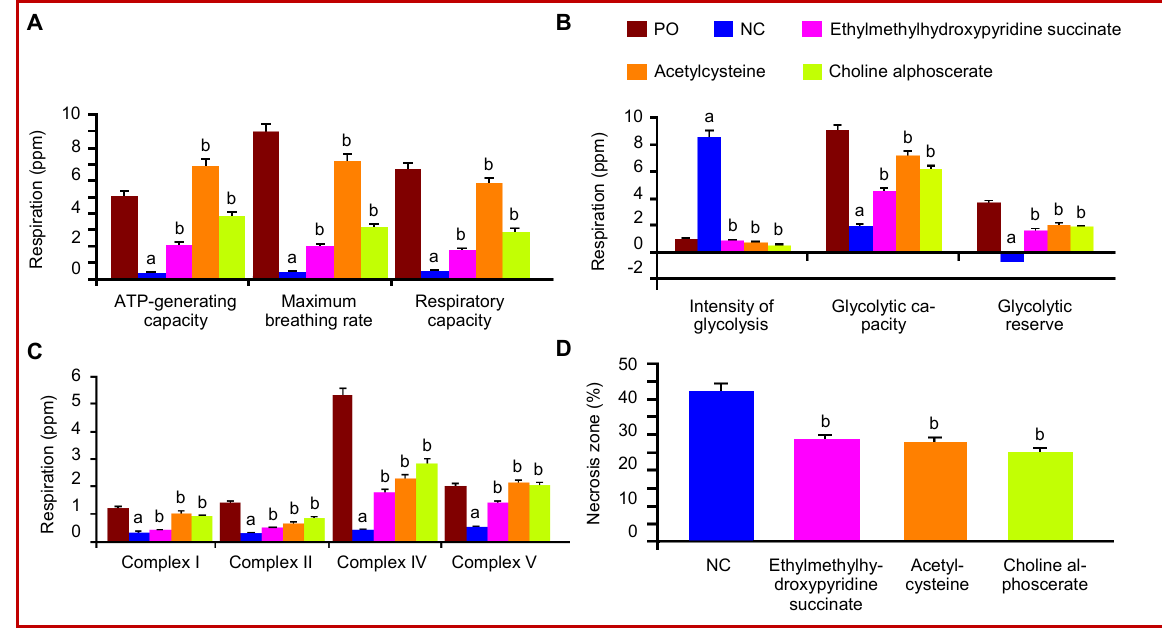
Figure 2: The effect of the test-objects on the change of mitochondrial respirometric function (A), process of glycolysis (B), mito- chondrial respiratory chain complexes (C) and size of the brain necrosis zone (D) in rats under conditions of cerebral ischemia. Note: a statistically significant relative to the pseudo-operated (PO) group of animals (p<0.05, Newman-Keuls criterion); b statistically significant rela- tive to the negative control (NC) group of animals (p<0.05, Newman-Keuls